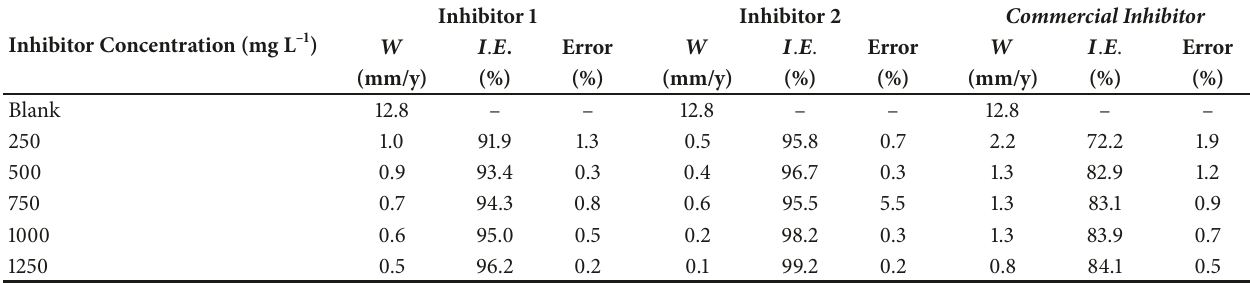
Table 2: Inhibitor efficiencies and corrosion rates to carbon steel in 1.0 mol L – 1 HCl solution with different concentrations of inhibitors, after immersion for 24 h at 25 ∘